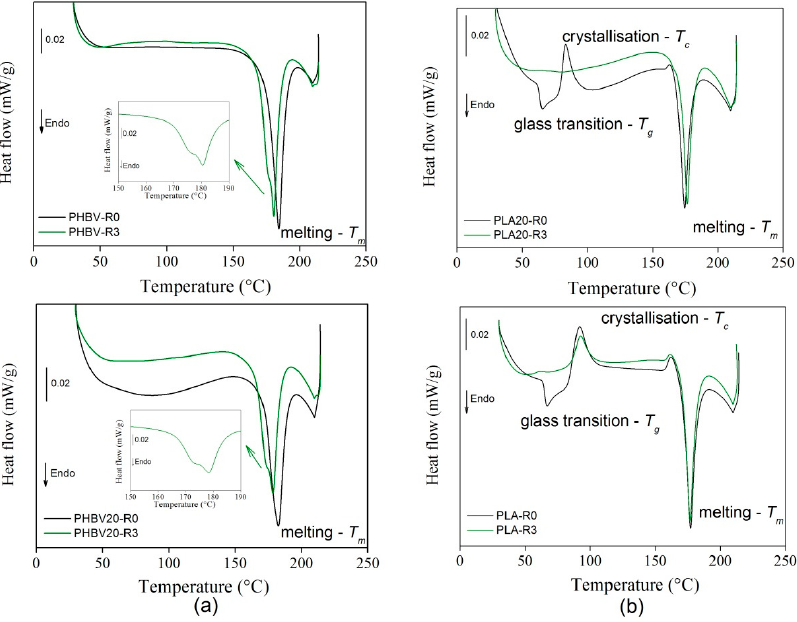
Figure 9. Calorimetric curves for recycled (R3) PHBV and PHBV20 ( a ) and PLA and PLA20 ( b ) and comparison with unrecycled samples (R0).